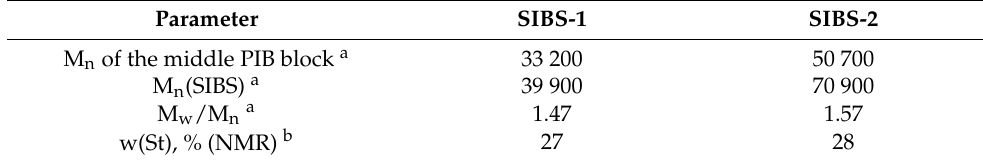
Table 1. Properties of